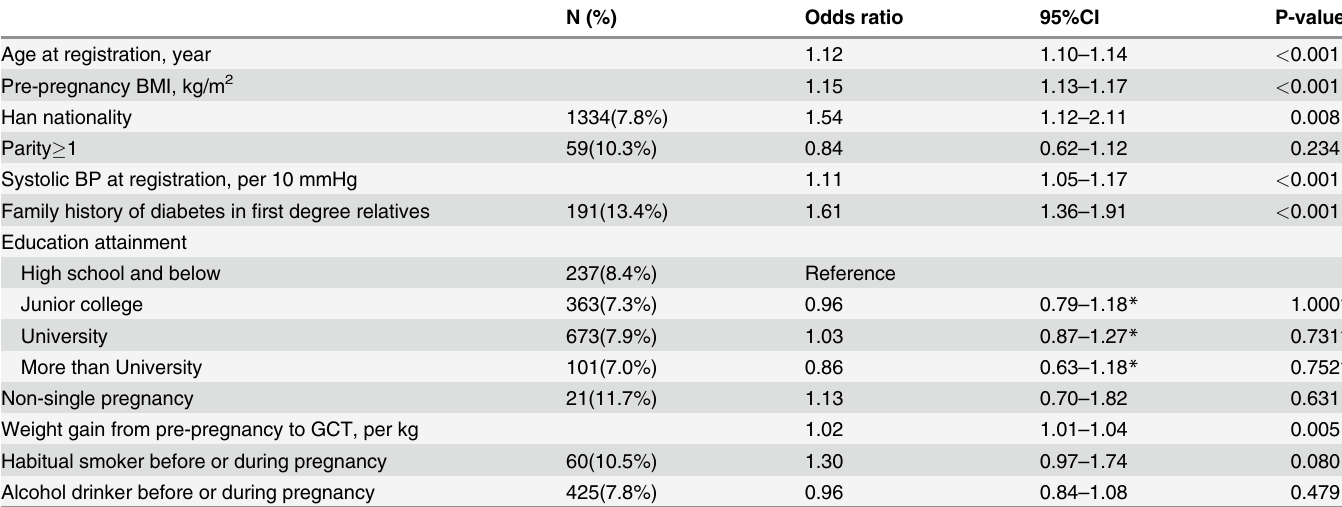
Table 4. Multivariable odds ratios of potential risk factors for gestational diabetes mellitus diagnosed by the IADPSG criteria. N (%) Odds ratio